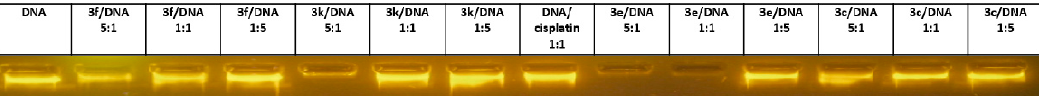
Figure 3. DNA intercalation with EtBr: 1 h incubation with derivatives 3c , 3e , 3f , and 3k (5/1, 1/1 and 1/5 w / w ) ( μ g derivative/ μ g DNA).